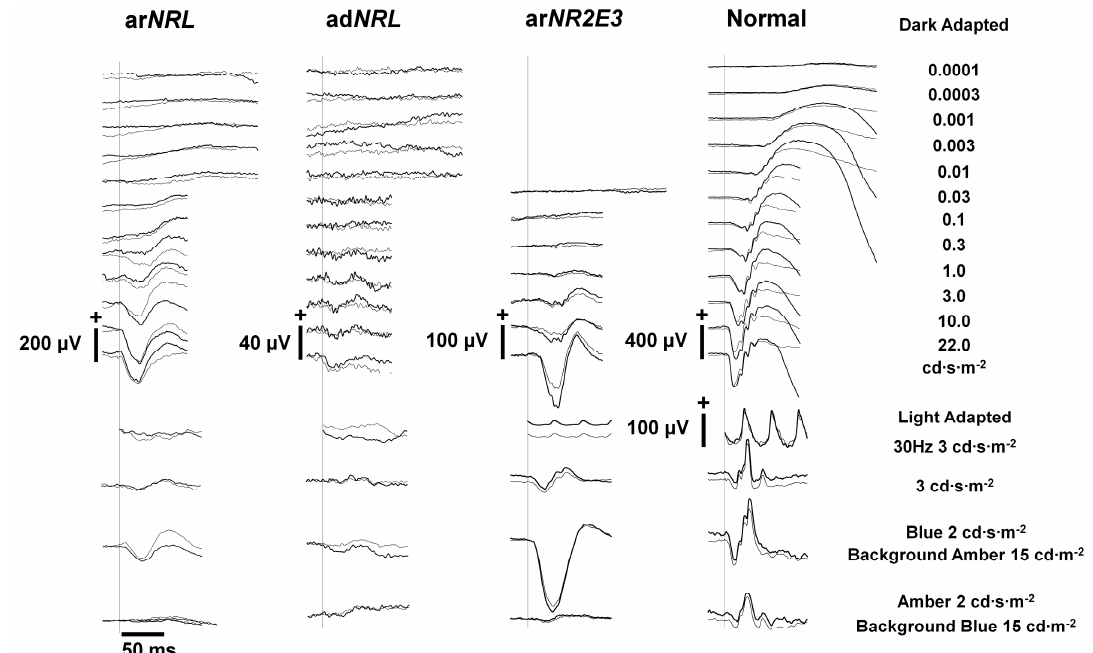
Figure 2. Electroretinography of subject 32594 with ar NRL mutations. ERG results of proband 32594 with ar NRL mutation c.508C>A and c.654del. The dark-adapted ERG shows absent rod responses for low stimulus strengths and reduced combined rod-cone responses for high stimulus strengths, with constant a-wave latencies despite increasing stimulus strength. The light-adapted ERG shows reduced and delayed responses to a 3 cd·s·m − 2 stimulus (cone response). Light-adapted responses show a relatively high amplitude for a blue stimulus on an amber background, and reduced responses for an amber stimulus on a blue background. Also shown are ERG results of age-matched individuals with autosomal dominant NRL mutation c.152C>A (ad NRL ) with retinitis pigmentosa, homozygous NR2E3 mutation c.119-2A>C (ar NR2E3 ) with ESCS, and a normal individual.